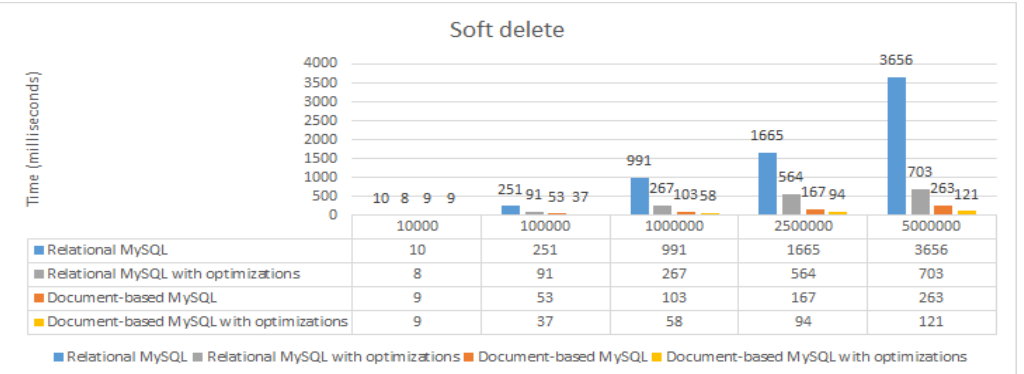
Figure 14. Performance time (ms) for the soft delete operation. The soft delete operation is an update in which several elements and a single field are modified. The duration of the query is due to the joins between the tables, with the update itself being fast. The differences in duration are quite significant between the two databases before optimization, especially when the number of elements increases due to the join and the lack of an index on the deleted